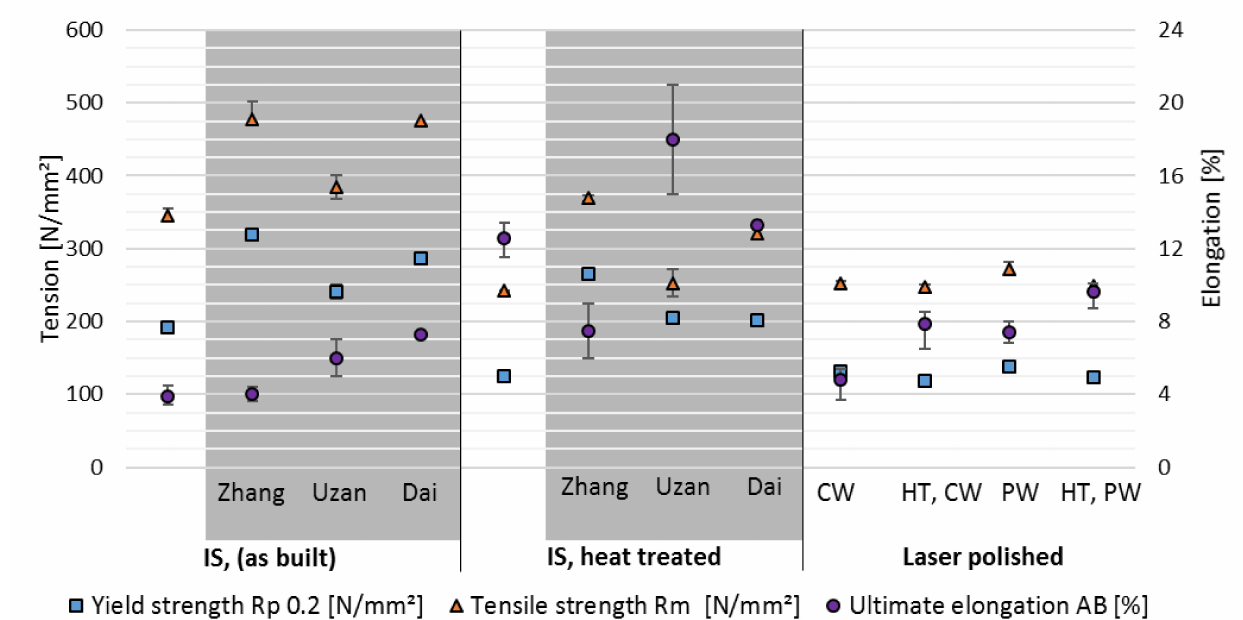
Figure 27. Mechanical properties of L-PBF AlSi10Mg between the L-PBF state (IS, as built), after heat treatment of 300 ◦ C, 2 h (IS, heat treated) and after laser polishing the surface with continuous and pulsed laser radiation on the initial state (CW, PW) and after previous heat treatment (HT, CW; HT, PW) in comparison to Zhang [34], Uzan [32] and Dai